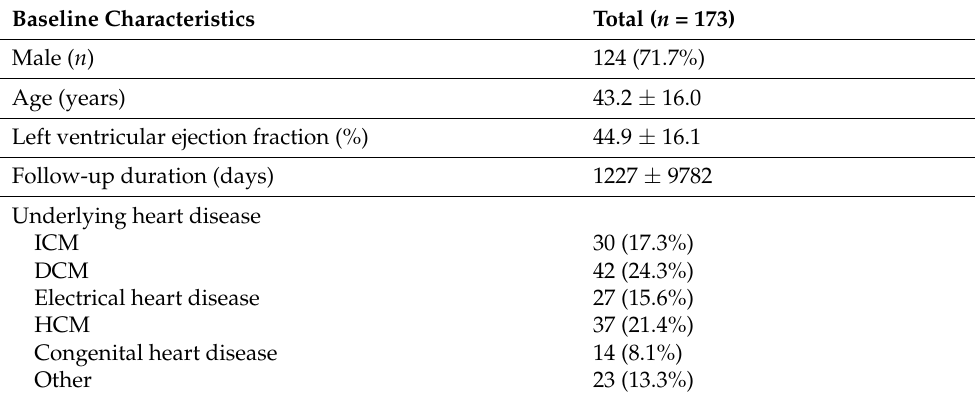
Table 1. Baseline characteristics of the patient